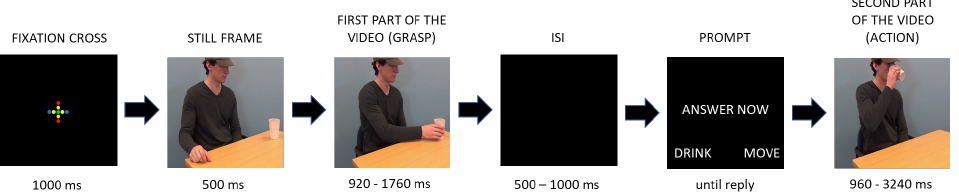
Figure 2. The course of one example trial presented with still frames. The exact timing of each part differed between the stimulus videos (see bottom). ISI—inter-stimulus